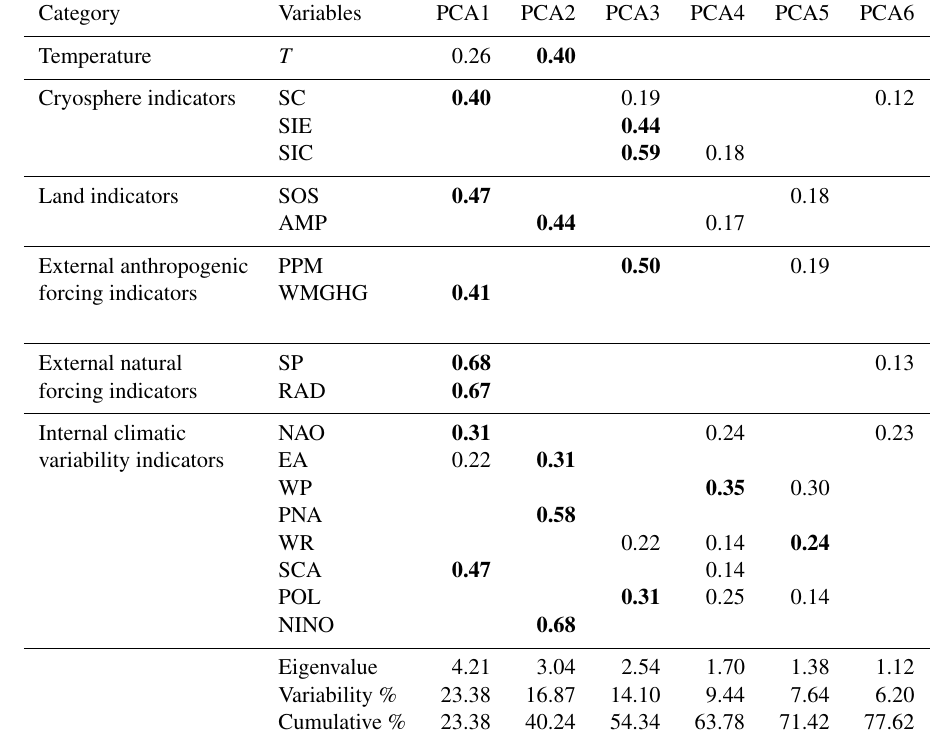
Table 3. Squared loading of variables for 1982–2011. Category Variables Temperature Cryosphere indicators